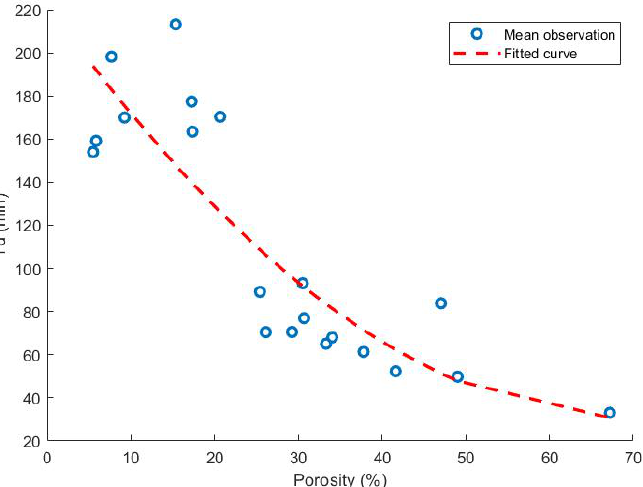
Figure 10. The correlation between the time at which 63.2% of the API is dissolved (Td) and the porosity as measured by helium pycnometry. Reported observations are the mean values of three repetitions of each run. Second order polynomial fitting was performed with an obtained R 2 of